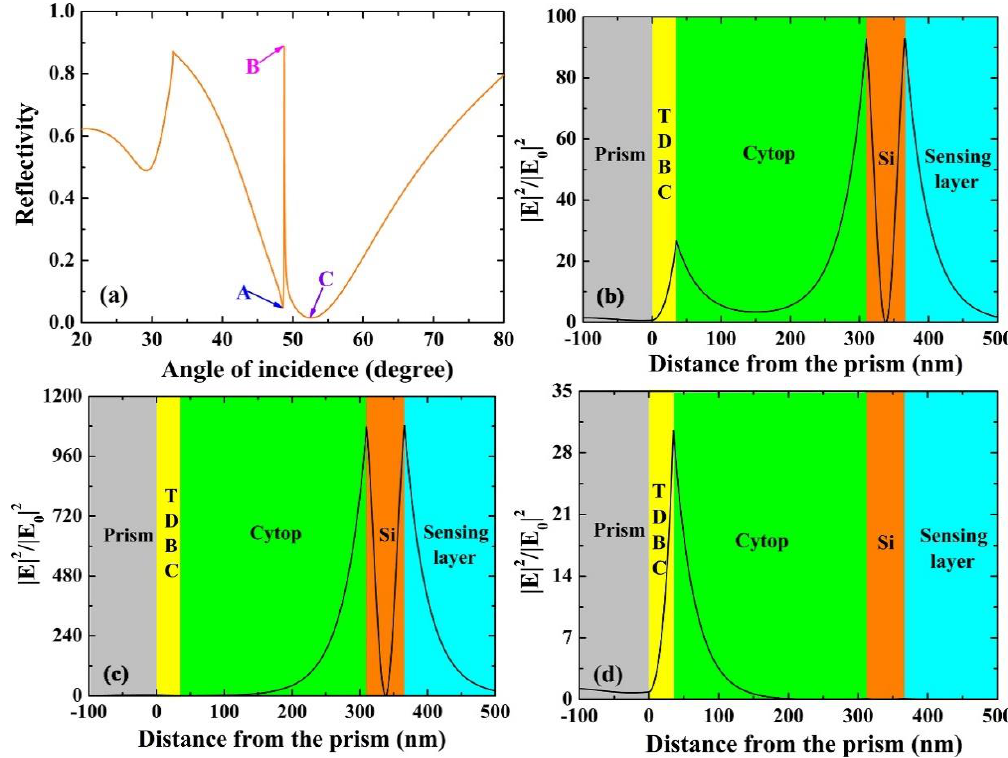
Figure 3. ( a ) The angular reflection spectra calculated as a function of the angle of incidence with d 1 = 35 nm, d 2 = 300 nm, and d 3 = 56 nm. ( b – d ) present an electric field (|E X | 2 /|E 0 | 2 ) corresponding to the three dips denoted as “ A ” , “ B ” and “ C ” in Figure 3a,